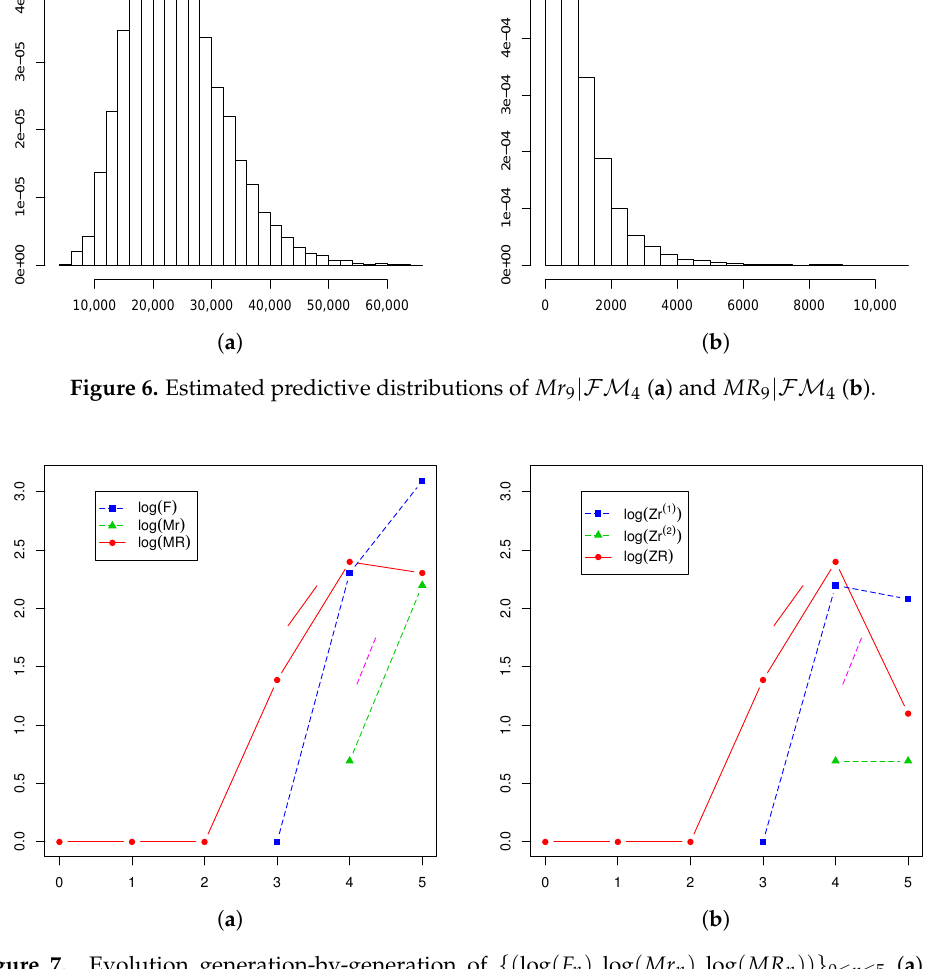
( ρ ) (solid straight line) and log ( ρ 1